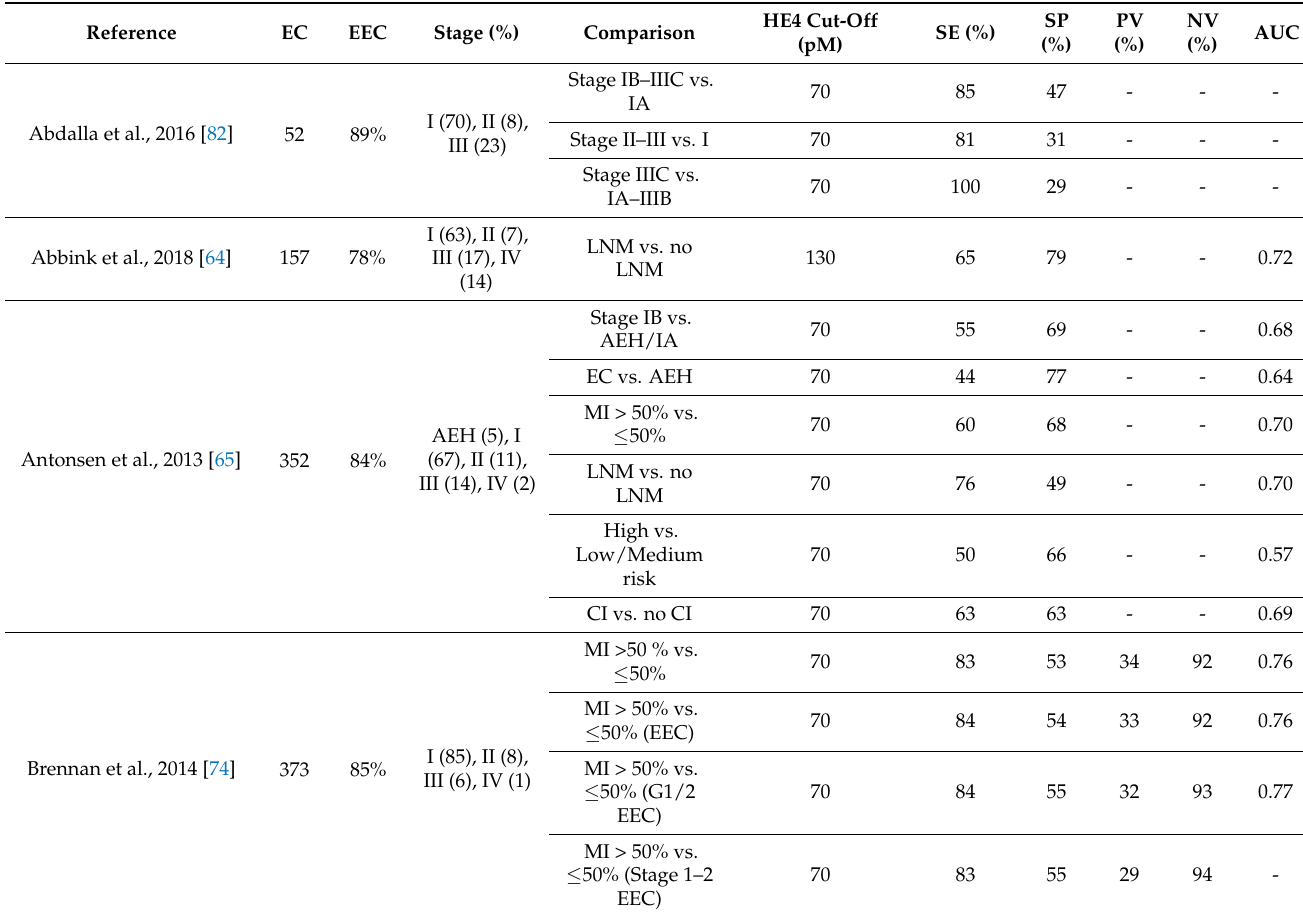
Table 2. Serum HE4 cut-off values and performance for EC prognostic